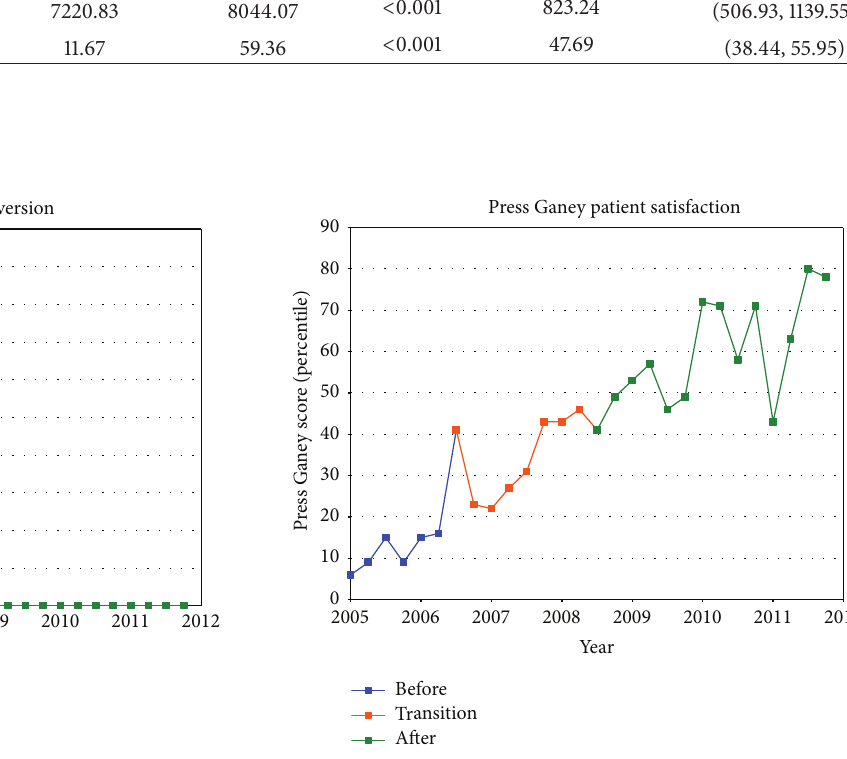
Figure 2: Hours of ambulance diversion. The quarterly number of hours the ED spent on diversion (refusing to receive ambulances).